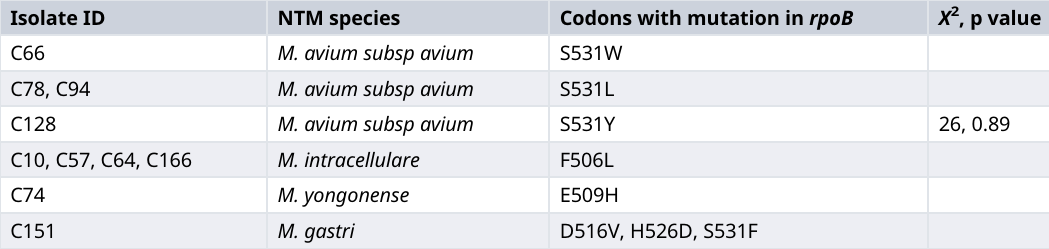
Table 5. Slow- growing NTM showing mutations associated with rifampicin resistance.